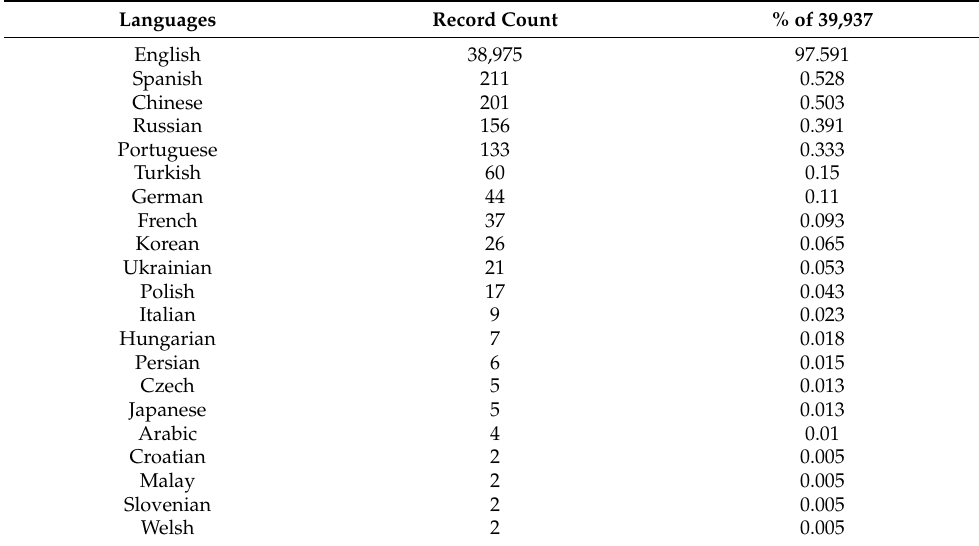
Table 14. Languages used as a medium for publications (2019–2021) for which publication count is